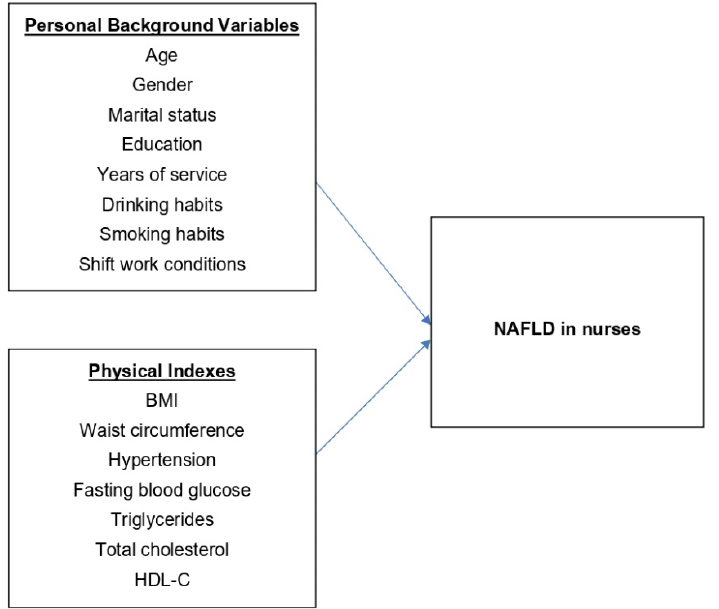
Figure 1. Research framework of factors influencing the incidence of NAFLD in nurses.